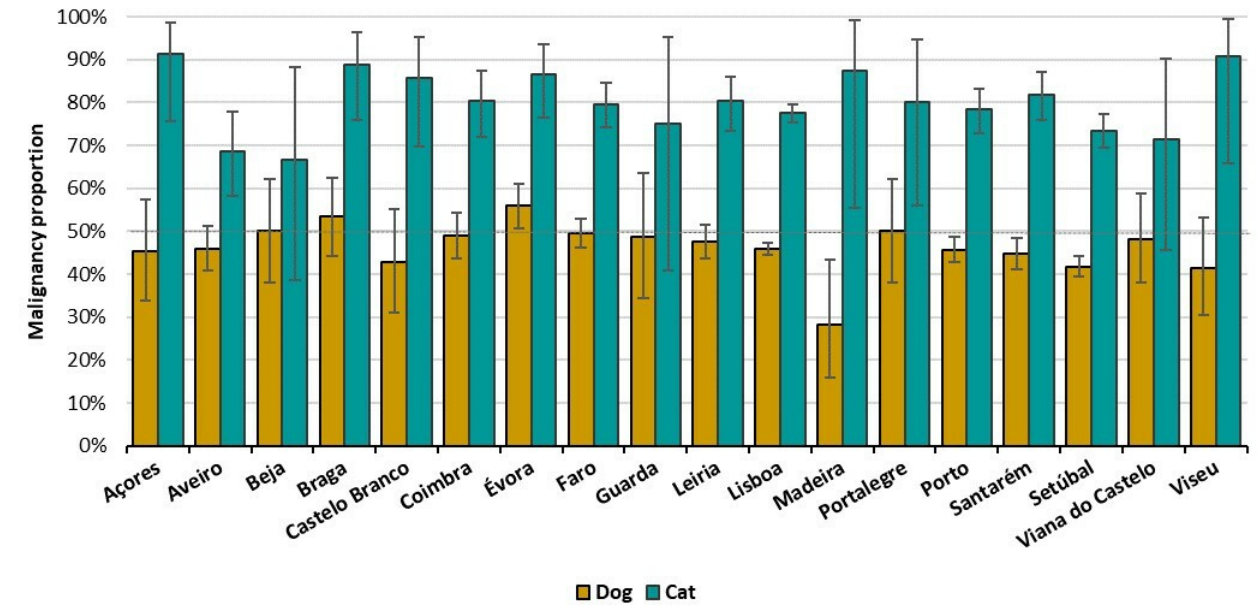
Figure 4. Malignancy proportion per district by species: dogs (yellow) and cats (blue). Bars indicate 95%CI. Dashed line represents 50% of malignant tumors.